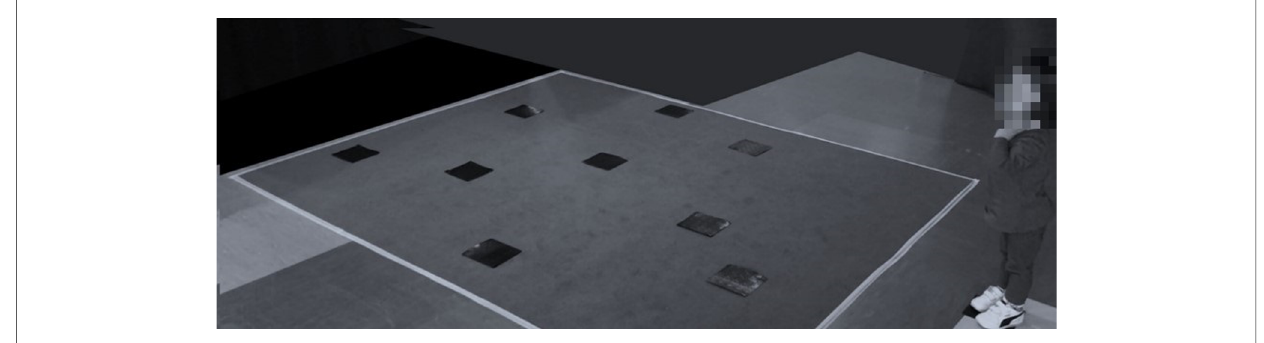
FIGURE 1 Child performing AWalCT. The toddler stands in front of the reduced carpet waiting The Examiner to start the